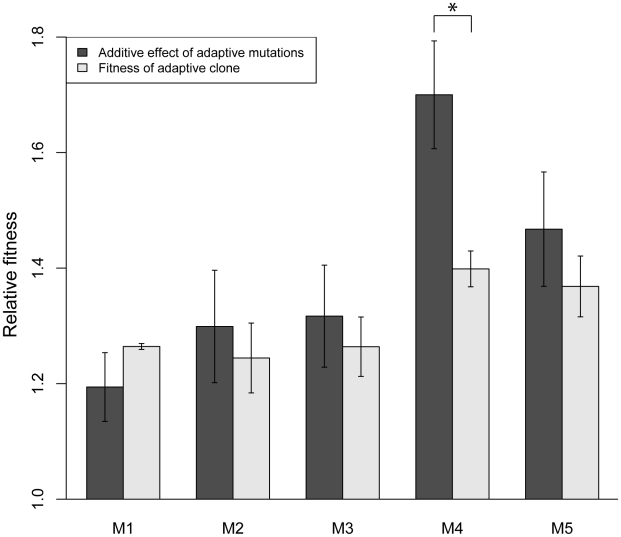
Adaptive mutations recapitulate fitness of adaptive clones M1–M3 and M5.For each adaptive clone, the fitness effects of each adaptive mutation from Figure 2 were added and compared to the relative fitness of the clone. The additive effects recapitulate the relative fitness of clones M1–M3 and M5, and there is evidence of negative epistasis between the two adaptive mutations in M4, since the additive fitness effect of the mutations is significantly larger than the relative fitness of the clone. Error bars are standard deviation. (*) indicates significance at α = 0.05. Relative fitness data of clones are from [25].